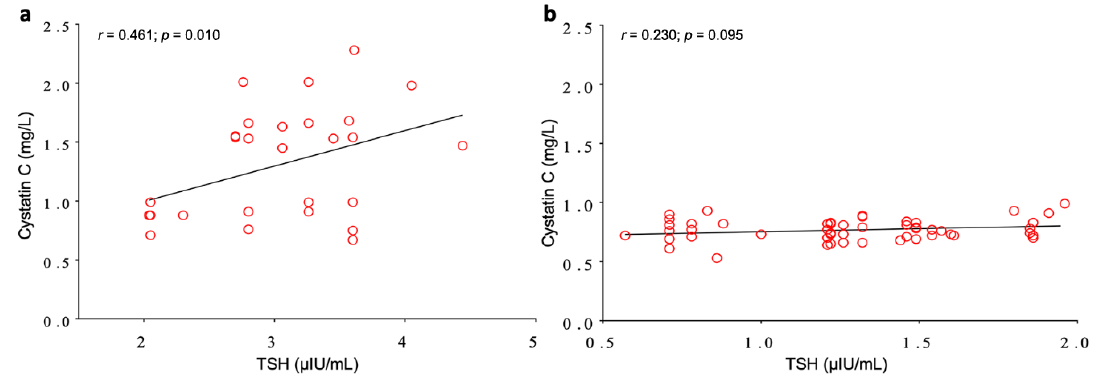
6 of 11 Figure 2. Pearson’s correlation analysis between TSH and renal functional parameters in the total study population. ( a ) TSH vs. creatinine; ( b ) TSH vs. mGFR; ( c ) TSH vs. CKD-EPI eGFR; ( d ) TSH vs.